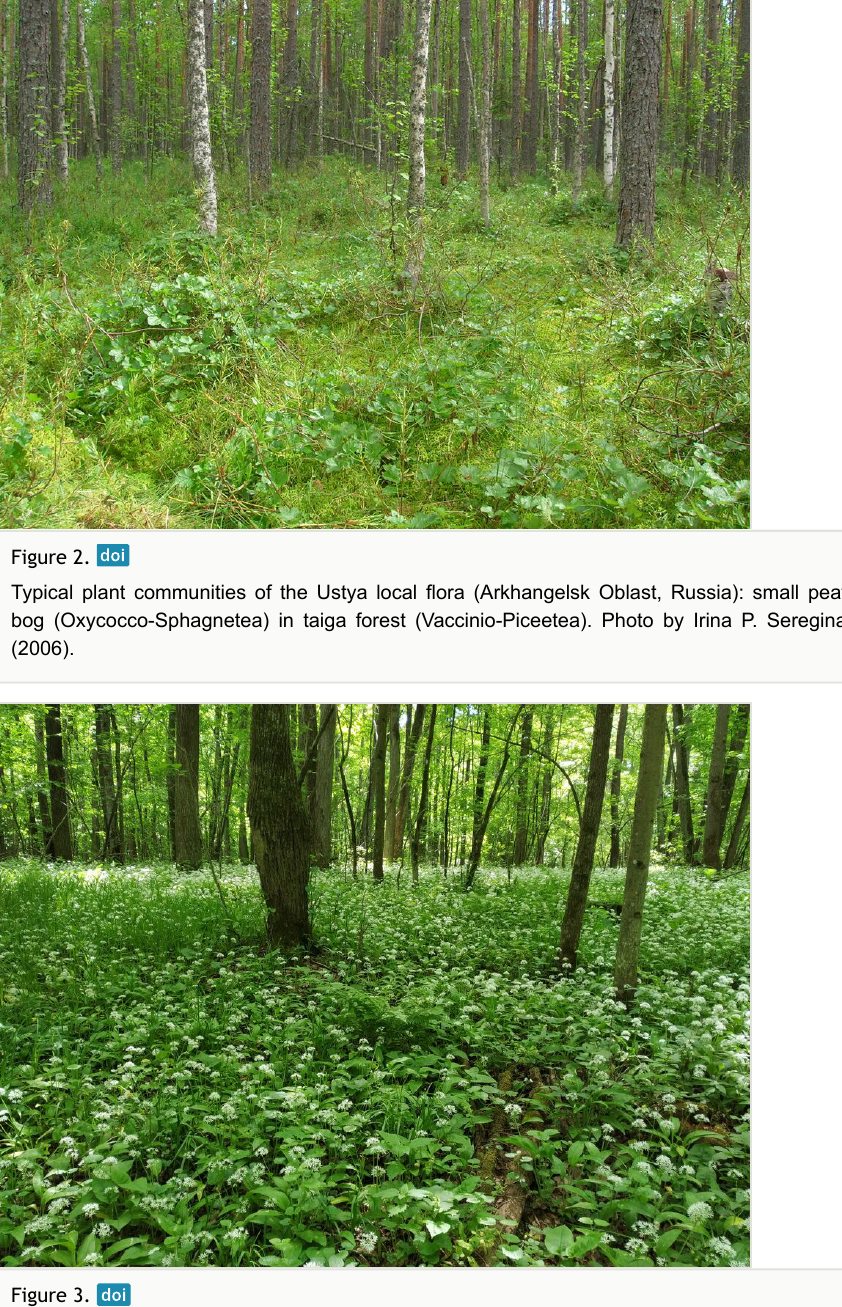
Typical plant communities of the Zaseki local flora (Tula Oblast, Russia): broadleaved forest (Querco-Fagetea) with Allium ursinum L. Photo by the author